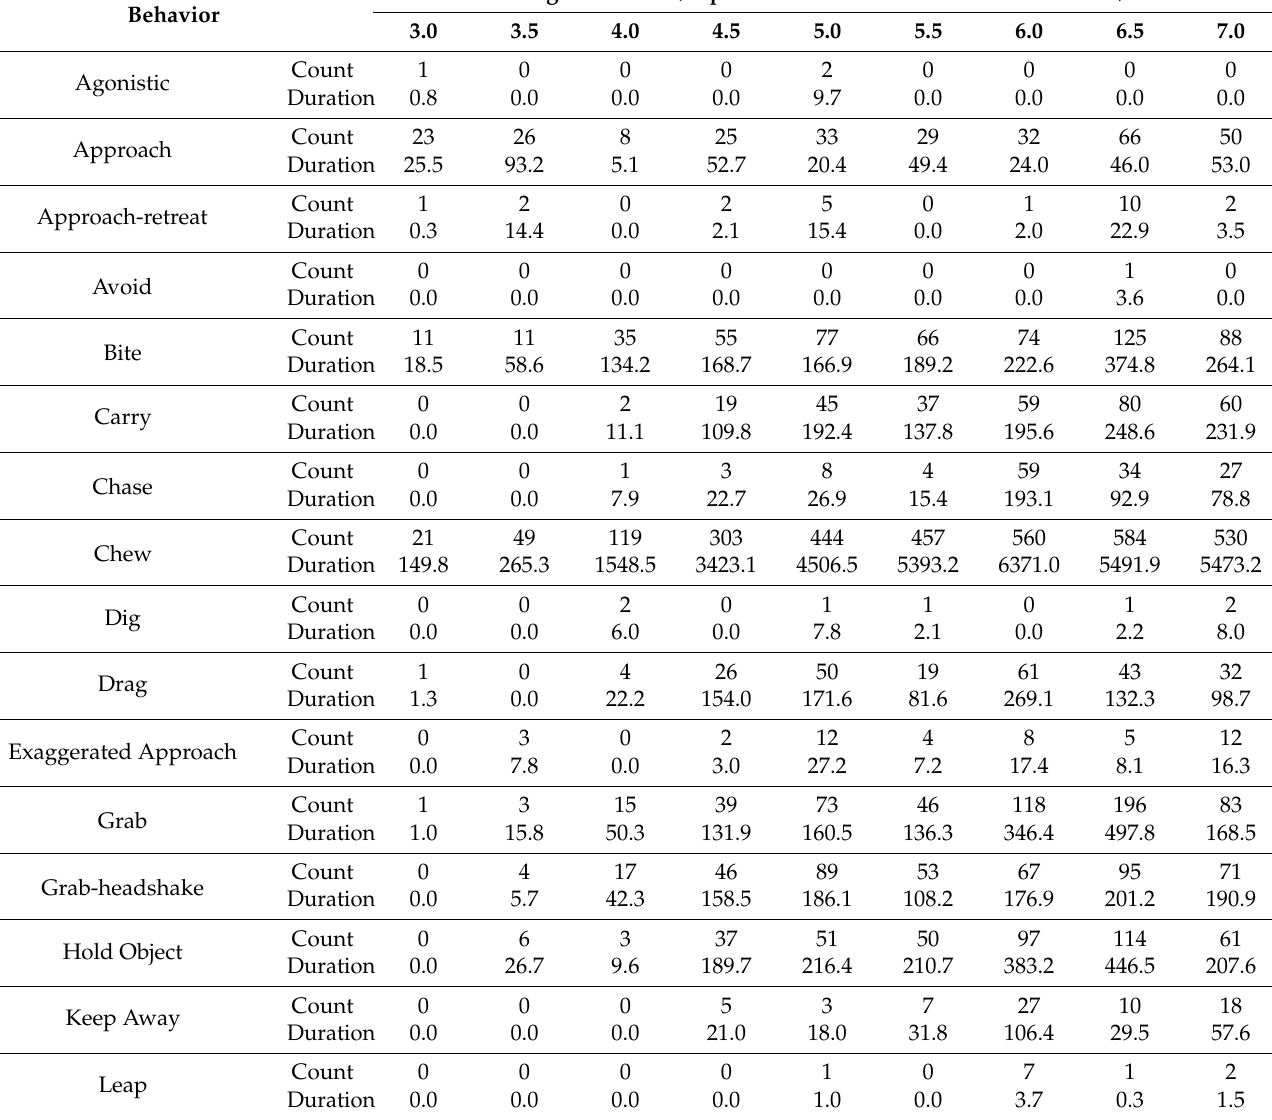
Table A5. Bi-weekly Frequency of Individual behaviors collapsed across breed. Total counts and duration (in seconds) for each behavior at each week and mid-week time point collapsed across